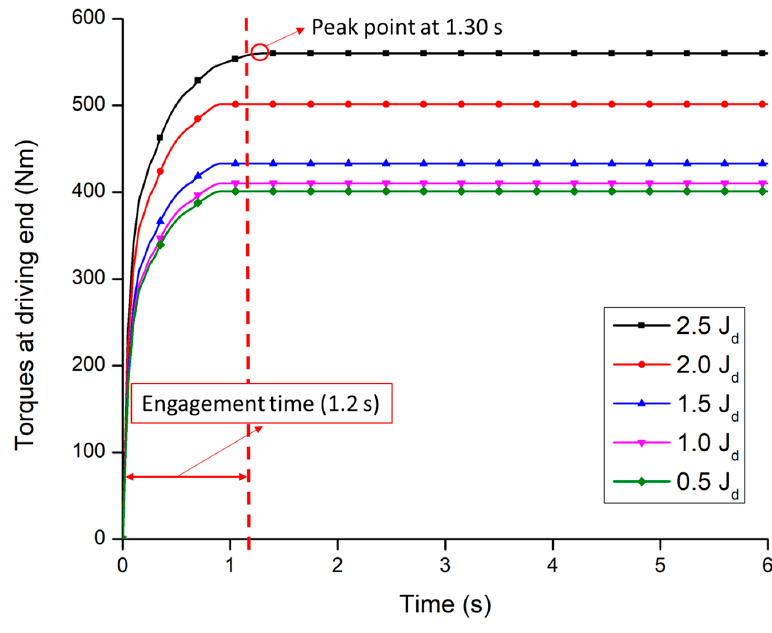
Table 4. The performance of the sliding velocity of the PST.